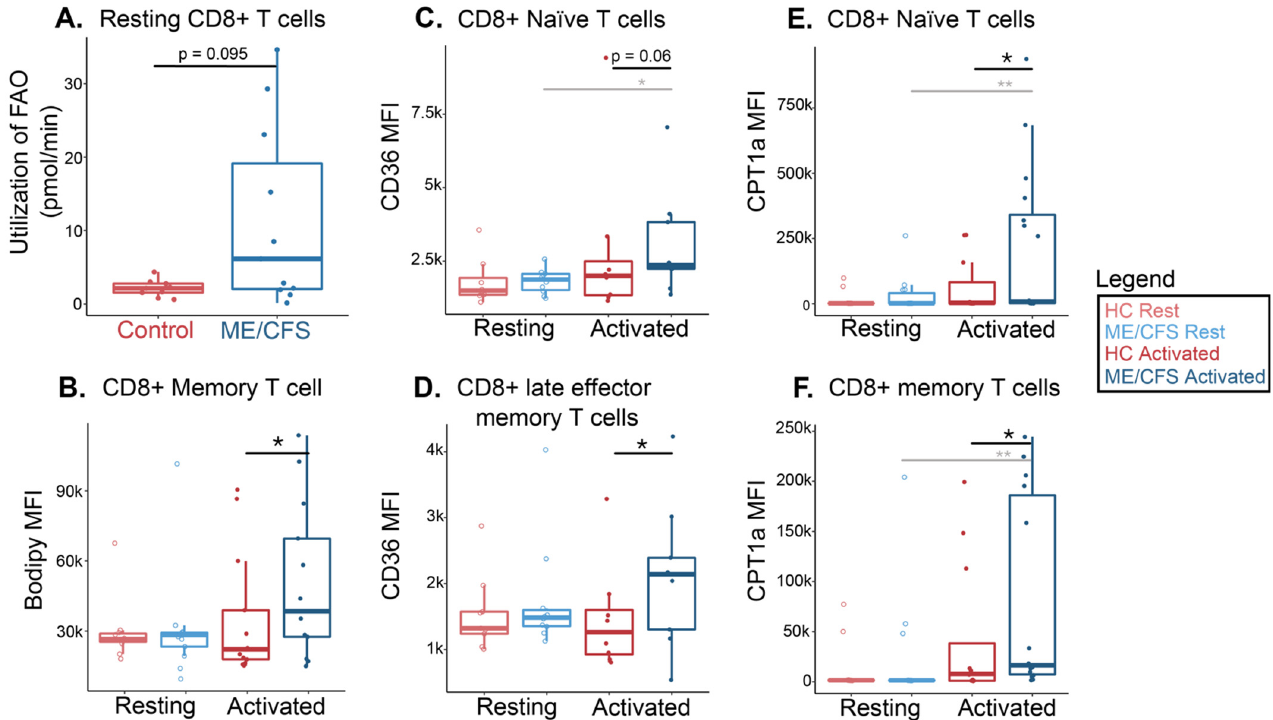
Figure 6. ME/CFS CD8+ T cells increased fatty acid oxidation compared to healthy controls. ( A ) Fatty acid oxidation measurements from a Seahorse extracellular flux analysis of circulating CD8+ T cells ( n = 9 healthy control samples; n = 11 ME/CFS samples). Each dot represents the change in oxygen consumption rate (pmol/min) under high energy demands following the injection of etomoxir in one sample, with an average of 2–3 technical replicates. ( B ) Mean fluorescence intensity of a supplied fatty acid (Bodipy) in circulating and activated CD8+ memory T cells (CD27+CD28+CD45RA − ) ( n = 11 healthy control samples at rest; n = 13 ME/CFS samples at rest; n = 13 healthy control samples after activation; n = 13 ME/CFS samples after activation, [ n = 11/13/13/13]). ( C ) Mean fluorescence intensity of a fatty acid cell membrane transporter, CD36, in resting and activated CD8+ naive T cells (CD27+CD28+CD45RA+) ( n =8/10/8/9). ( D ) Mean fluorescence intensity of a fatty acid cell membrane transporter, CD36, in resting and activated CD8+ late effector memory T cells (CD27 − CD28 − CD45RA+) ( n =9/10/8/9). ( E ) Mean fluorescence intensity of a fatty acid mitochondrial transporter, CPT1a, in resting and activated CD4+ naïve T cells (CD27+CD28+CD45RA+) ( n =11/13/12/14). ( F ) Mean fluorescence intensity of a fatty acid mitochondrial transporter, CPT1a, in resting and activated CD4+ memory T cells (CD27+CD28+CD45RA − ) ( n =11/14/11/16). Box plots represent the median ± 25th and 75th quartiles. Whiskers represent 1.5× the interquartile ranges. Outliers are values outside the whisker range. Healthy control and ME/CFS data points are light (resting) or dark (activated) red or blue, respectively. For Seahorse data, * p < 0.05 by Wilcoxon rank-sum test. For flow cytometry data, * p < 0.05 and ** p < 0.01 by Kruskal–Wallis followed by Dunn’s test with FDR-based multiple testing correction. Gray lines and */** indicate a significant difference between ME/CFS and ME/CFS or healthy control and healthy control cohorts before and after stimulation.